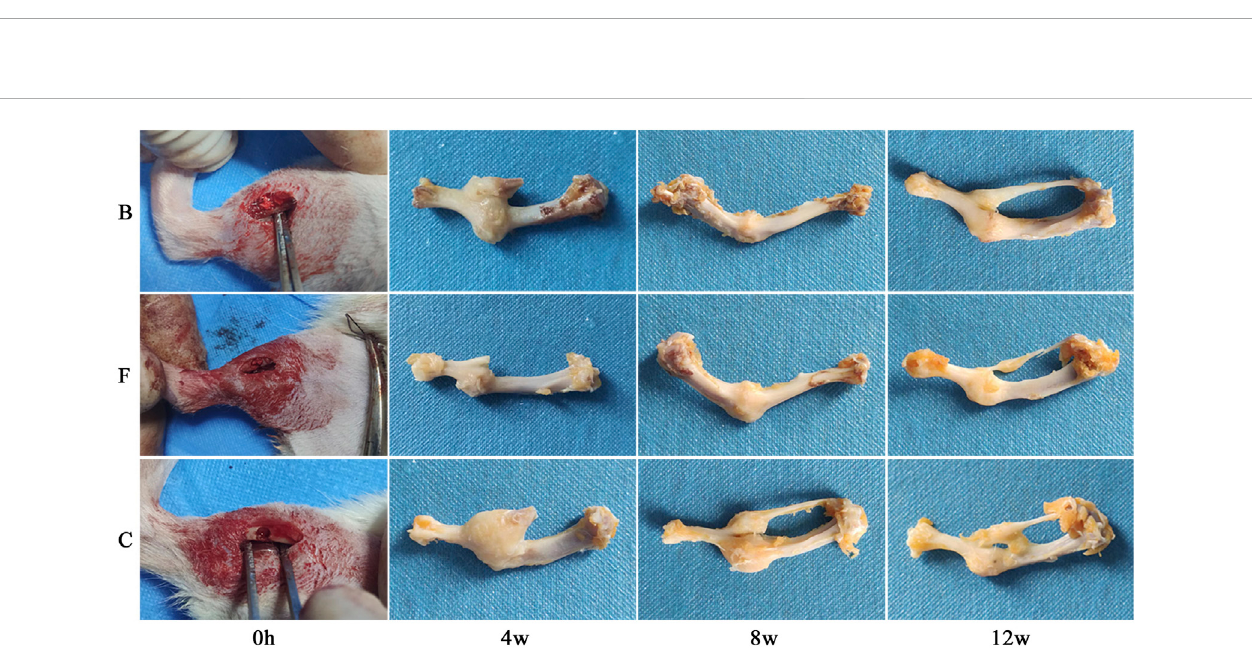
Frontiers in Bioengineering and